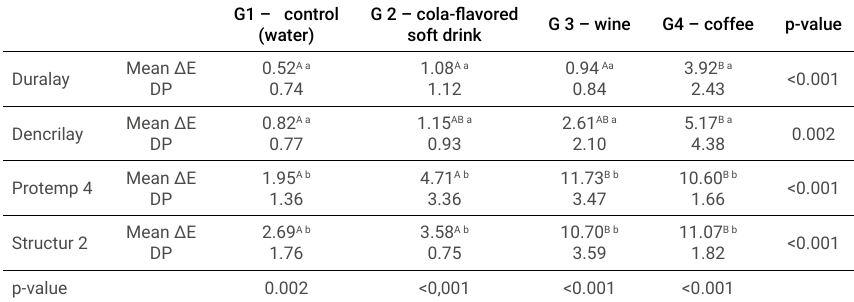
Table 2. Mean and standard deviation of color changes (ΔE) of acrylic and bis-acrylic resins submitted to different staining